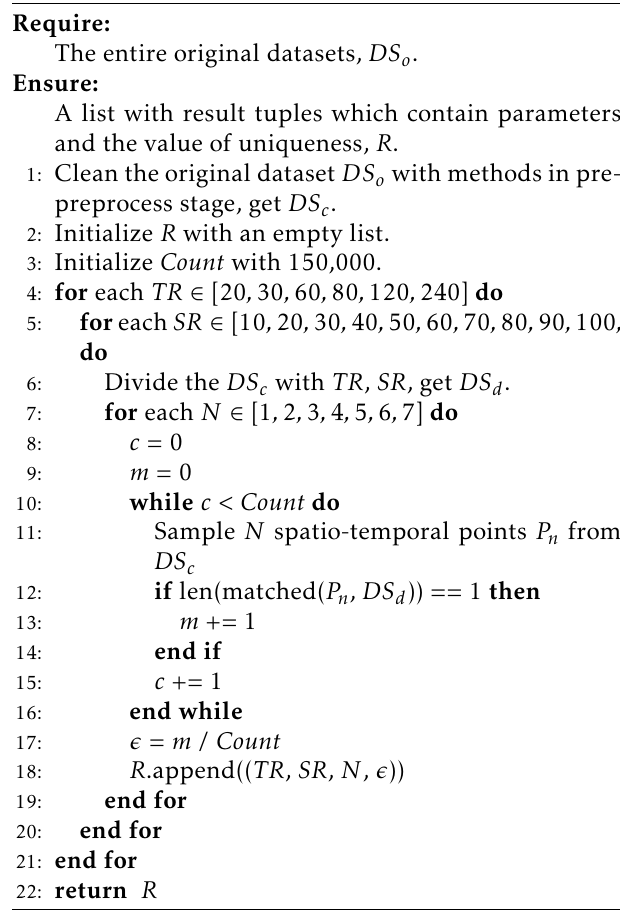
Algorithm 1 Computing Uniqueness of Traces